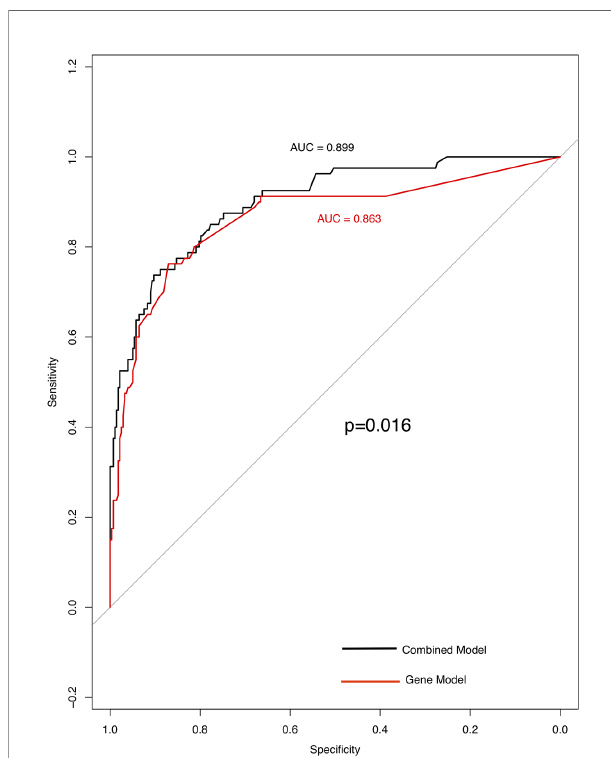
FIGURE 4 | High speci fi city of genes and clinical model for predicting TMB status. ROC curve analysis was used to determine the sensitivity and speci fi city of the two models. The black curve is the combined model; the area under the ROC curve is 0.899(95% con fi dence interval: 0.861 – 0.938). Curve in red is gene model; the area under the ROC curve is 0.863 (95% con fi dence interval: 0.811 –